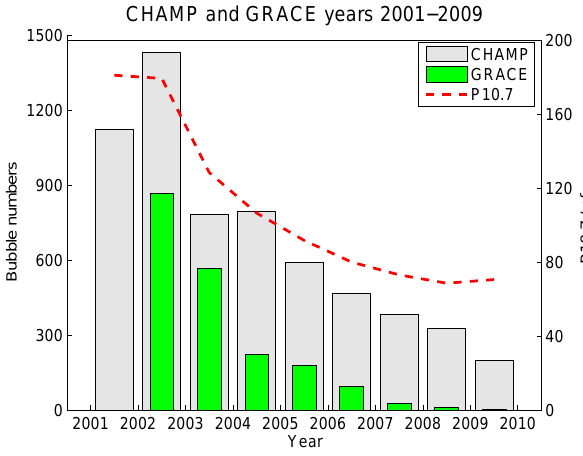
Fig. 4. EPB detections per year from CHAMP and GRACE obser- vations for 2001–2009. The gray and green bars are the EPB num- bers obtained from CHAMP and GRACE data, respectively, and the red dashed line represents the annual averages of solar